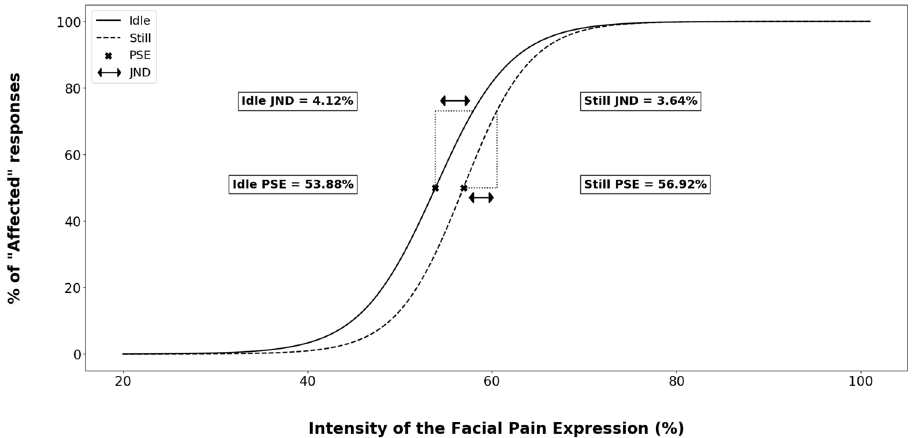
Figure 4. Logistic modelling of “Touched” responses according to facial pain expression intensity in the still and idle conditions . PSE and JND correspond to the mean of PSE and JND obtained from the modelling of each participant.